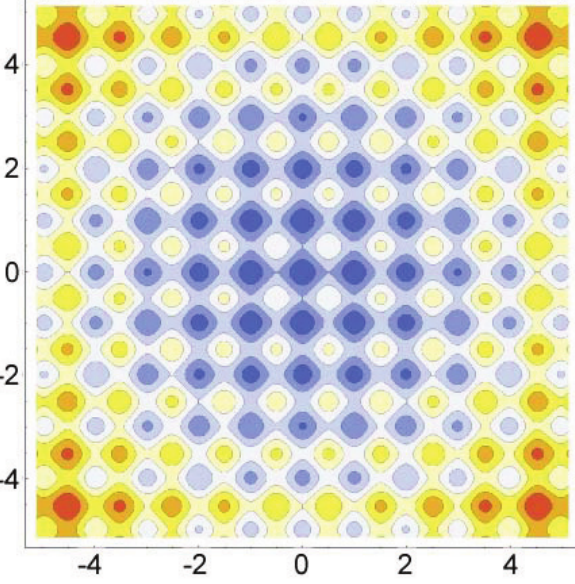
Figure 4. Contour plot of the Rastrigin function. Visualized in Mathematica 8: ContourPlot[10*2 + x^2 + y^2 – 10 Cos[2 Pi x] –10